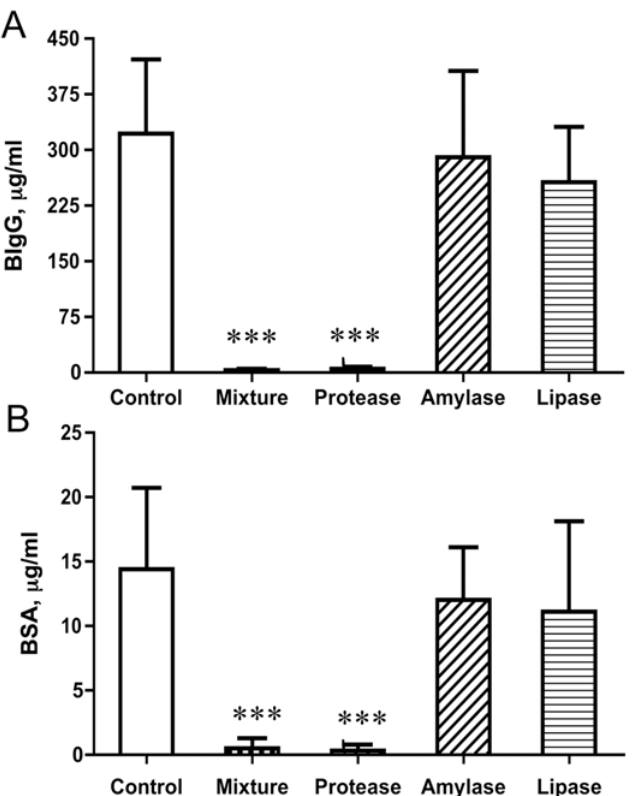
Fig 2. Blood plasma levels of the marker molecules, bovine IgG (BIgG, A) and bovine serum albumin (BSA, B), 3h after their oro-gastric administration to 17 d-old rats that had been treated by gavage feeding with different microbial-derived enzymes, a protease, amylase, lipase, and a mixture thereof, or water (control) during 14 – 16 days of age. Statistically significant differences between control and enzyme-treated groups (mean ± SD, n = 7) are indicated by *** P < 0.001.